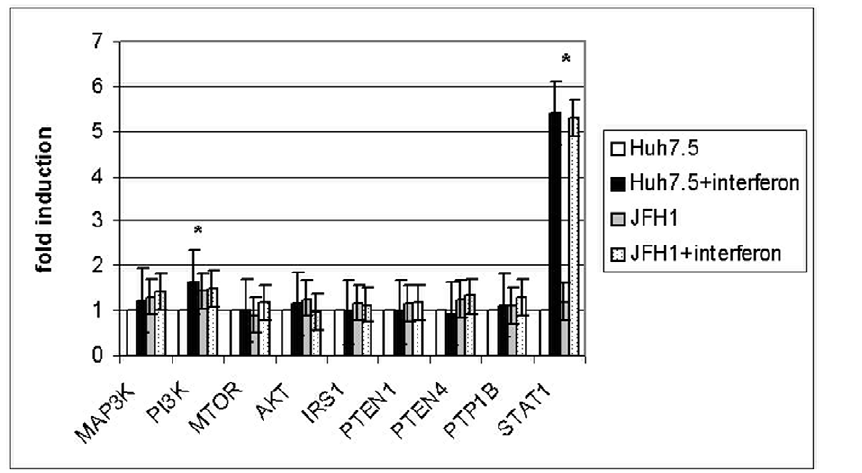
Figure 2. Interferon effect on insulin pathway gene expression. Huh7.5 cultures were treated with 500 IU/ml and infected with JFH-1 particles. Experiments were performed in triplicate. Control experiment (non-infected cells and no insulin added) was used as a reference (fold induction=1). (*)=p , 0.05.